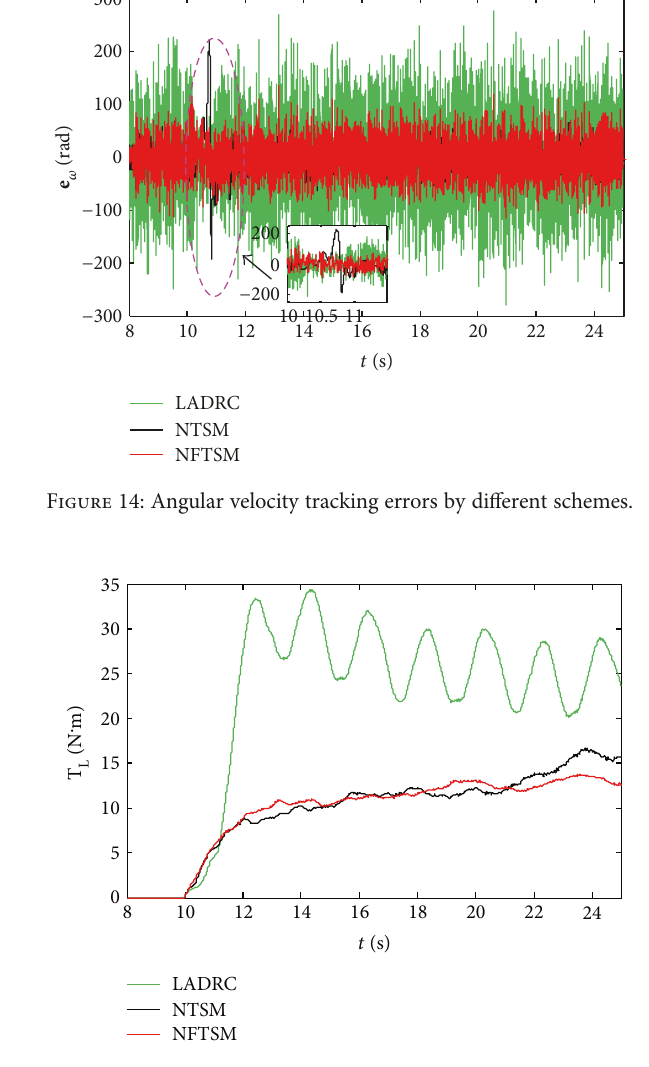
Figure 13: Angular velocity tracking results by di ff erent schemes. Figure 15: Load torques by di ff erent schemes.